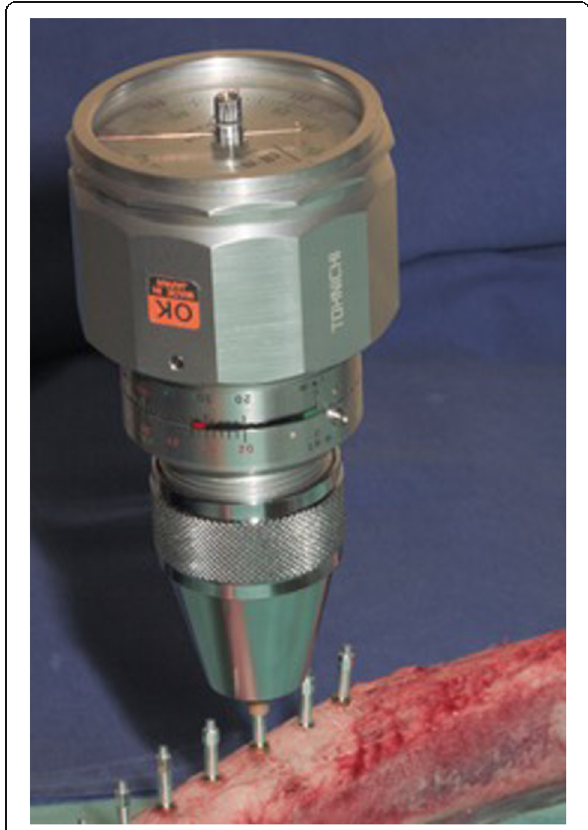
Fig. 1 Insertion torque and unscrewing device. Determination of insertion torque of individually hand-tightened smartpegs in test group by recording the removal torque required when unscrewing the device (BTG36N Analog Torque Meter, Tohnichi Manufacturing Co. Ltd., Tokyo, Japan)